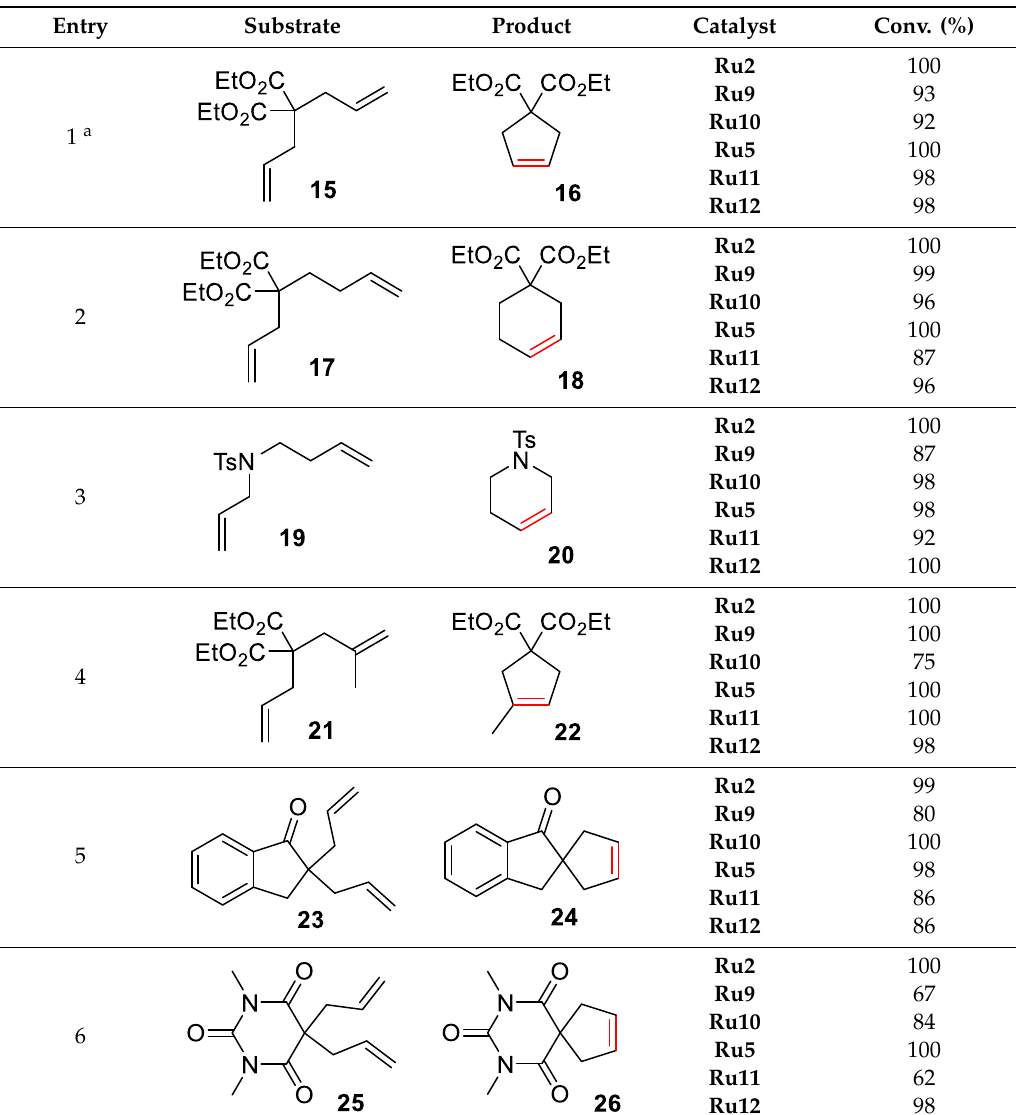
Table 2. Application of fluorene-based catalysts Ru9 – Ru12 in RCM reactions.